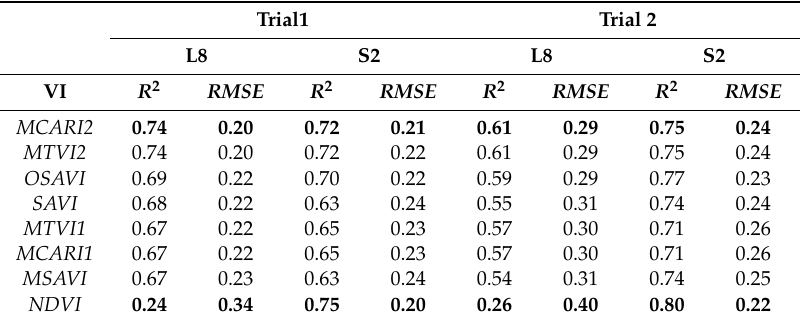
Table 4. Relationships between LAI e and the VIs estimated from L8 and S2 for Trial 1 and Trial 2. Second Modified Chlorophyll Absorption Ratio Index ( MCARI2 ) (the best performance among the Soil-Line VIs) and NDVI are shown in bold.